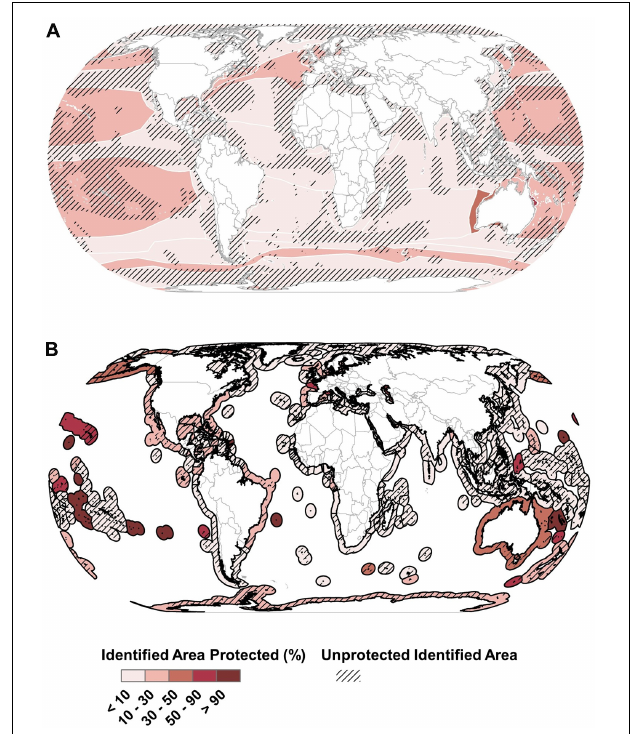
FIGURE 4 | Map showing what percent of area identified as important is currently within a marine protected area by (A) marine province (MEOWs, Marine Ecoregions of the World: Spalding et al., 2007; PPOWs, Pelagic Provinces of the World: Spalding et al., 2012) and (B) Exclusive Economic Zone (EEZs, Exclusive Economic Zones: Flanders Marine Institute, 2018). Areas were identified as important by six United Nations and four non-governmental organization initiatives that vary in purpose and scope. The boundaries of provinces in (A) are outlined in white and of EEZs in (B) are outlined in black; due to the spatial scale of the map, most MEOWs are not discernable. Representativeness, measured as the percent of identified area that was protected within each EEZ or MEOW/PPOW, was low: fewer than a quarter of EEZs and a half of marine provinces had at least 10% of their identified area protected (lightest shade of pink). Every marine province and nearly every EEZ has areas identified as important but not currently protected (hatched area). Countries are displayed using data provided by Natural Earth (Admin 0 Countries 4.1.0; Natural Earth,